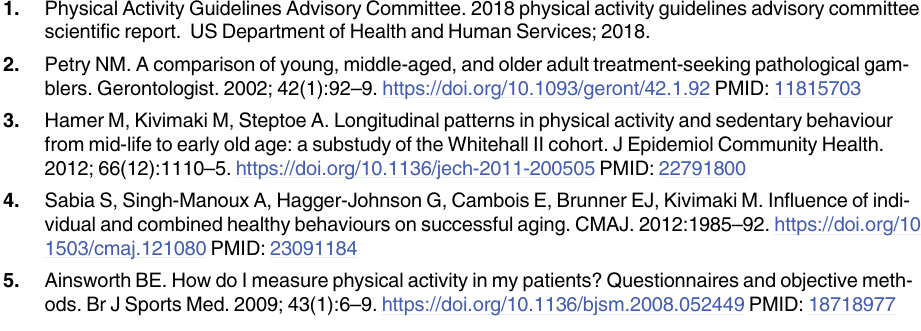
S4 Table. Summary of multivariate models examining the association between physical activity as measured by the active Australia survey and the SenseWear Armband ™ with BMI as a moderating factor. S5 Table. Summary of multivariate models examining the association between physical activity as measured by the active Australia survey and SenseWear Armband ™ with chronic disease as a moderating factor. S6 Table. Summary of multivariate models examining the association between physical activity as measured by the active Australia survey and the Sensewear Armband ™ with cohabitation as a moderating factor. S7 Table. Summary of multivariate models examining the association between physical activity as measured by the active Australia survey and the physical activity recall